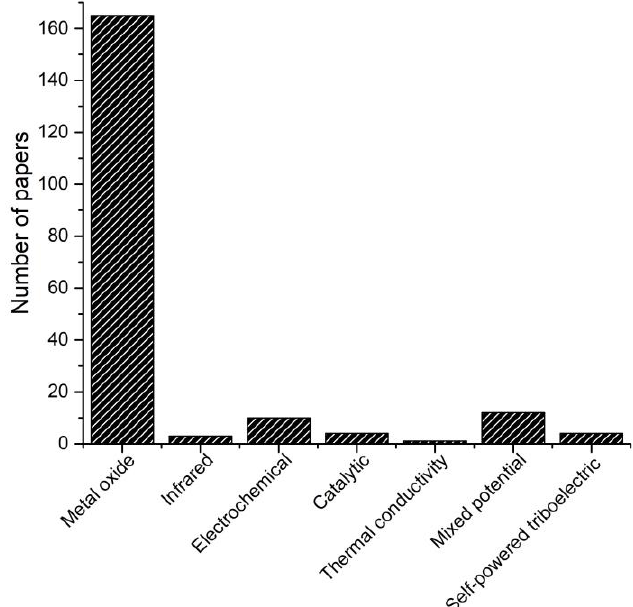
Figure 3. Results of the literature search (2018 – 2021) in the Elsevier and Scopus databases on acetone detection for different types of gas sensors.